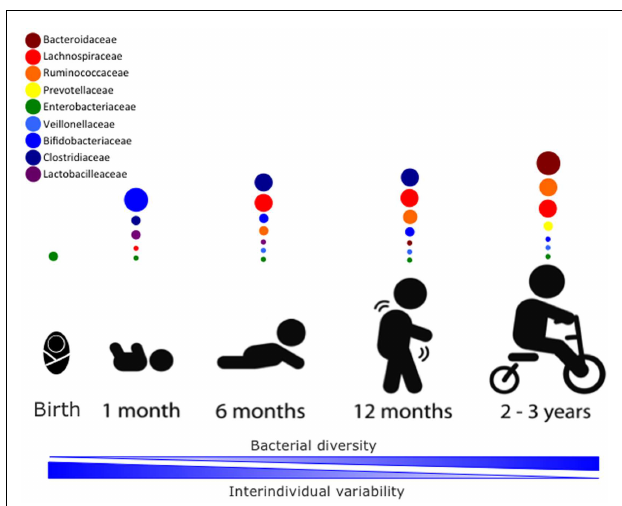
FIGURE 1 | Stages of microbial colonization of the infant and child intestine . Most abundant bacterial families are depicted in circles, where the size of the circle is proportional to the relative abundance of the bacterial taxa at each growth stage.The intestinal microbiota of the newborn is initially colonized by Enterobacteria . In the days after, strict anaerobic bacteria dominate the microbial community. During the first month, bifidobacterial species predominate in the gut, but the introduction of solid foods at around 4–6months is accompanied by an expansion of clostridial species (Lachnospiracea, Clostridiaceae, and Ruminococcaceae). Members of the Ruminococcaceae family continue to increase in abundance in the following months. By 2–3years of age, the microbiota composition consists of mainly Bacteroidaceae, Lachnospiraceae, and Ruminococcaceae, which then remains stable into